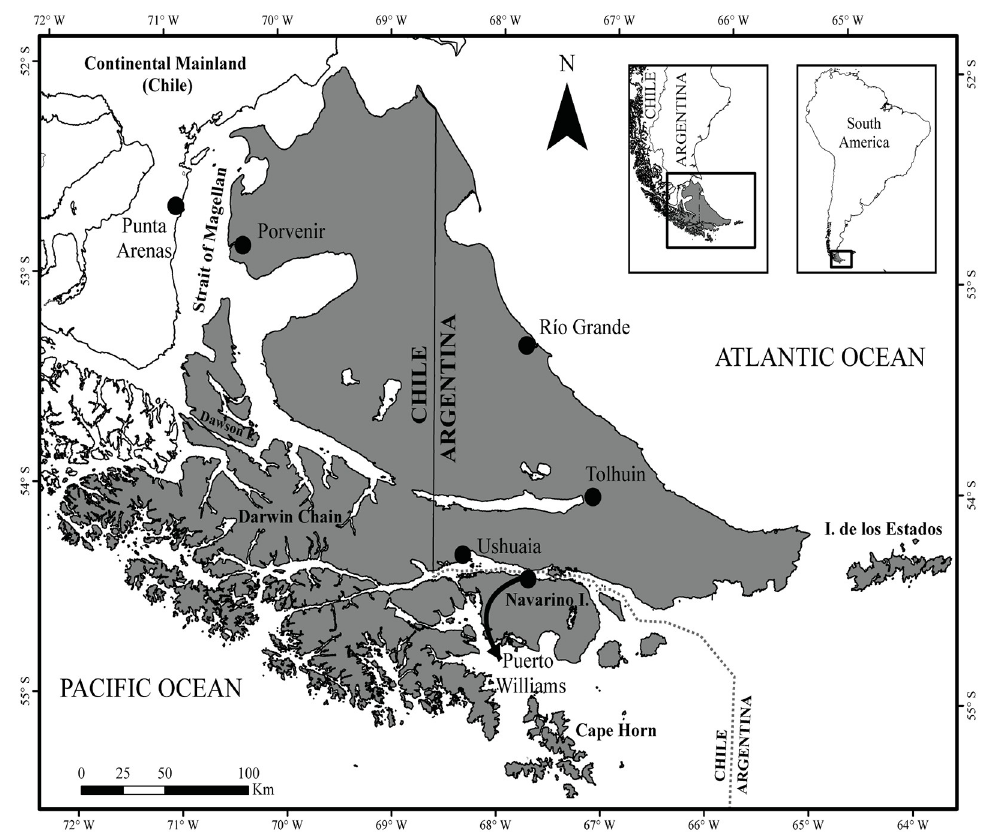
Fig 1. Study area. Archipelago of Tierra del Fuego showing the study area (dark gray) and the main cities in Argentina and Chile.